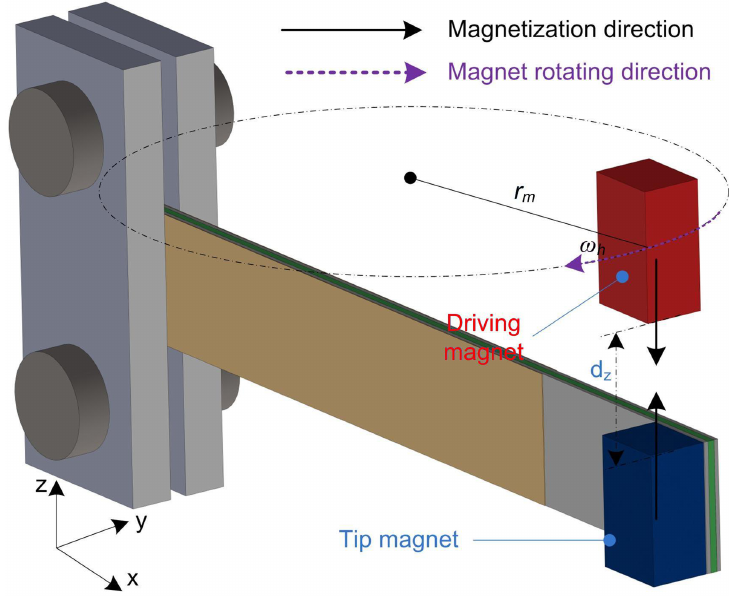
Figure 3. Strain distribution of a cantilever beam under tip